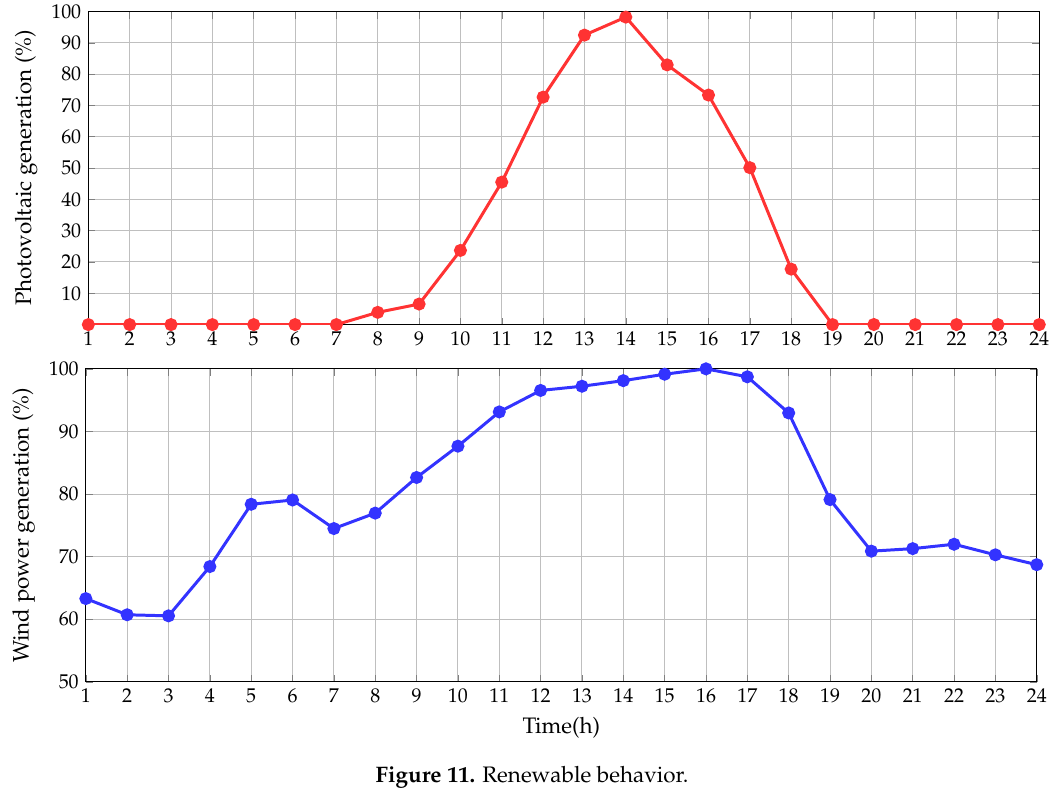
Figure 11. Renewable behavior.